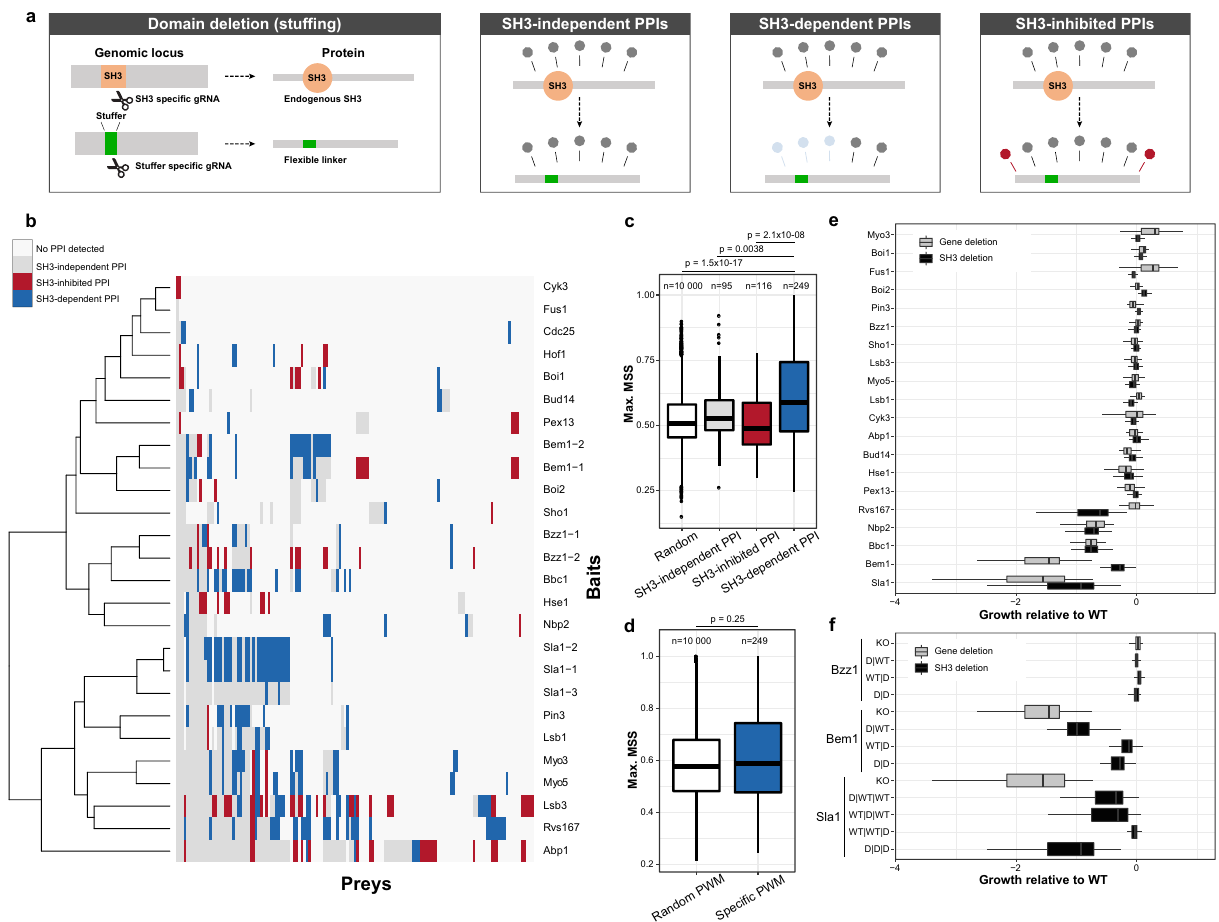
Fig. 1 De fi nition of SH3-dependent PPIs in vivo and their functional impact. a CRISPR – Cas9 SH3 editing approaches to study SH3 domains in living cells. For domain deletion (stuf fi ng), SH3 sequences are replaced by a stuffer sequence encoding a linker using CRISPR – Cas9. SH3 dependency can then be tested. b PPIs of WT and SH3-deleted proteins. Colors represent different types of PPIs (assessed in quadruplicate). c Matrix similarity scores (MSS) of SH3-speci fi c position weight matrices (PWMs) for prey corresponding to different types of PPIs from b . SH3-dependent PPIs are enriched for SH3-binding motifs relative to the Random, SH3-independent, and SH3-inhibited PPIs ( p = 1.5 × 10 − 17 , p = 0.0038 and p = 2.1 × 10 − 08 , Mann – Whitney test, one-tailed, n = 10,000 random protein sequences, n = 95 preys for SH3-independent PPIs, n = 116 preys for SH3-inhibited PPIs, n = 249 preys for SH3-dependent PPIs). For example, the proportion of high MSS SH3-binding motifs (95th percentile of the MSS distribution for random peptides) determined is 11/95 for SH3-independent, 5/116 for SH3-inhibited, and 75/249 for SH3-dependent partners. d PWM MSS for sequences of SH3-dependent preys (as in 1C), and for PWMs randomly assigned to SH3s ( p = 0.25, Mann – Whitney test, two-tailed, n = 10,000 random assignments of an SH3 PWM to an SH3 prey, n = 249 preys for SH3-dependent PPIs). e Growth of gene- or SH3-deleted strains compared to WT under 51 stress conditions. For Bzz1, Bem1, and Sla1, the data shows deletion of all SH3s. f Same as panel e , but for individual or combinations of SH3 deletions. D represents SH3 replaced with a linker sequence. Strains were grown in 12 replicates ( e , f analysis performed with n = 12 independent colony growth per strain). For every boxplot, the median is represented as a bold center line and hinges are for the 25th and 75th percentiles ( fi rst and third quartiles). Whiskers extend from the hinges to maximum 1.5 times the Q3 – Q1 interquartile range. For c , d , outliers are represented as black dots. Source data are provided as a Source Data fi le. See also Supplementary Data 1 and Supplementary Data